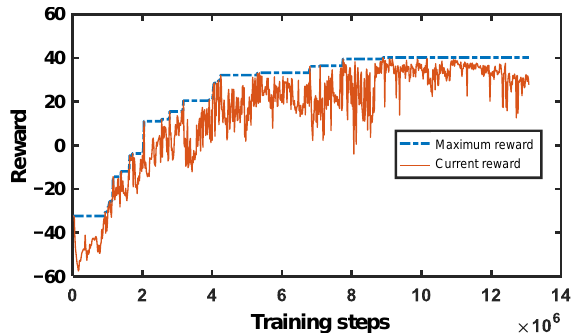
Figure 13. Reward function convergence curve.